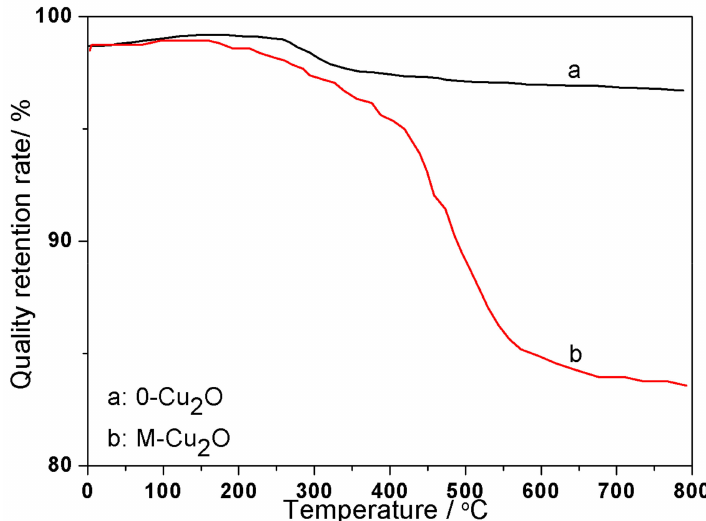
Figure 4. Thermogravimetric Analysis (TGA) of 0-Cu 2 O and M-Cu 2 O. ( a ) 0-Cu 2 O; ( b ) M-Cu 2